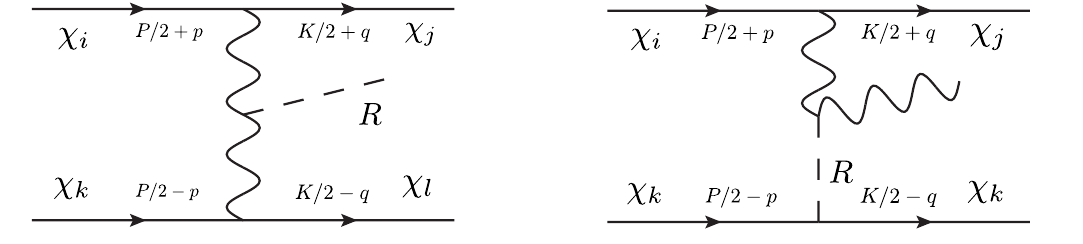
Figure 15 . Original diagrams of the emission from the mediators.